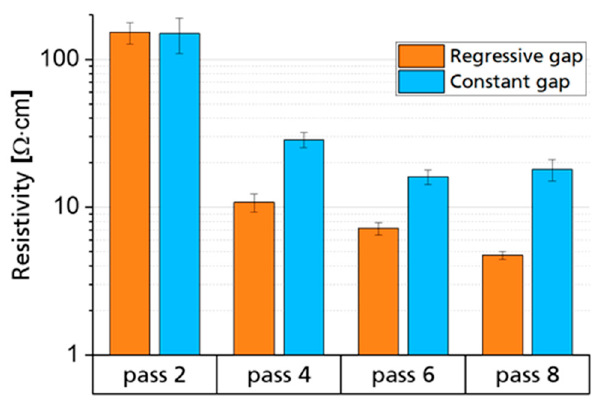
Figure 3. Electrical resistivity of SWCNT/epoxy 0.1 wt.% bar-shaped samples produced with two gap-modes in the three-roll mill and measured with the four-point method.